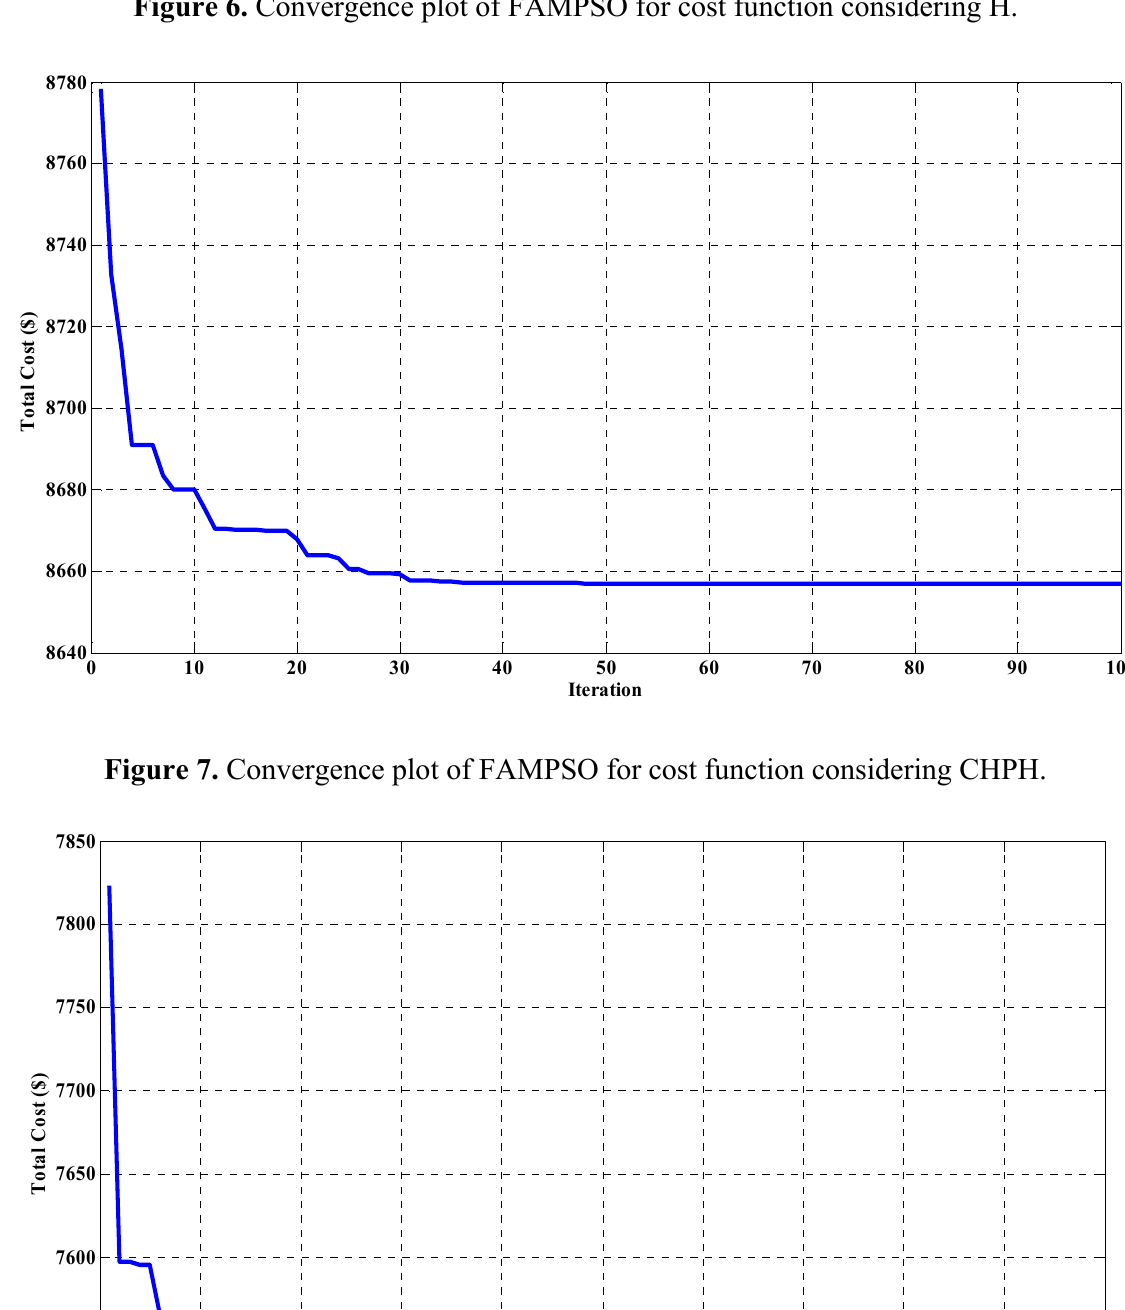
Figure 6. Convergence plot of FAMPSO for cost function considering H.